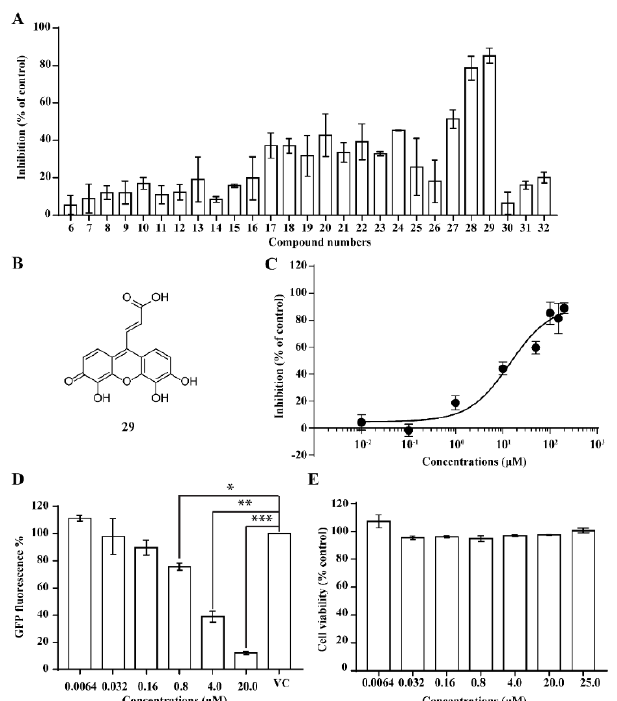
Figure 3. The competitive CD4 binding assay results of analogs of 3 ( A ). Among these analogs, 29 showed the best binding affinity with an IC 50 value of 14 µM ( B , C ). 29 inhibited HIV-1 infection in a dose-dependent manner ( D ), and a CellTiter Blue assay of 29 showed a complete lack of cytotoxicity effect ( E ).